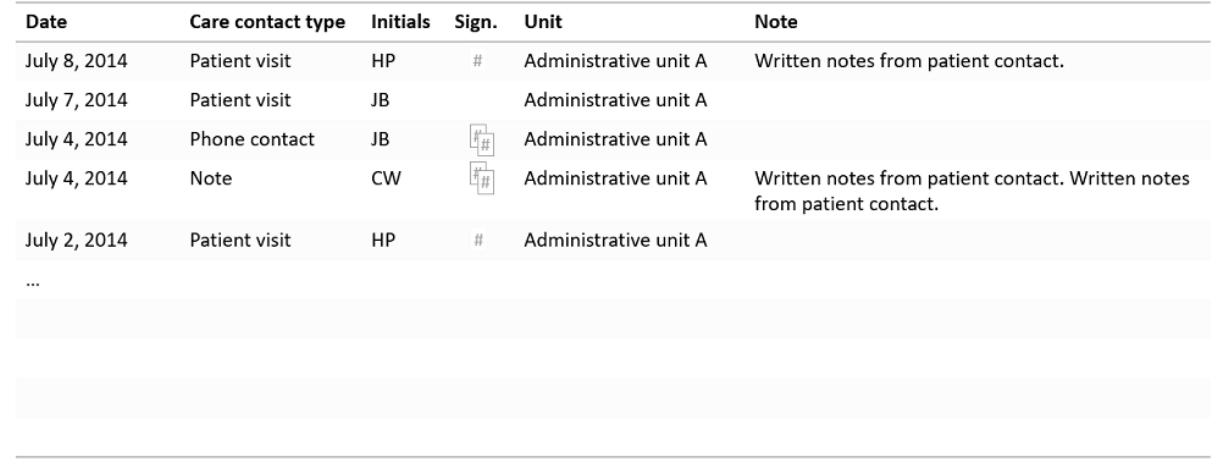
Figure 3. A different electronic health care record layout. This view presents information organized differently from the view shown in Figure 2; for example, the signing icons now appear in the center of the table and not to the